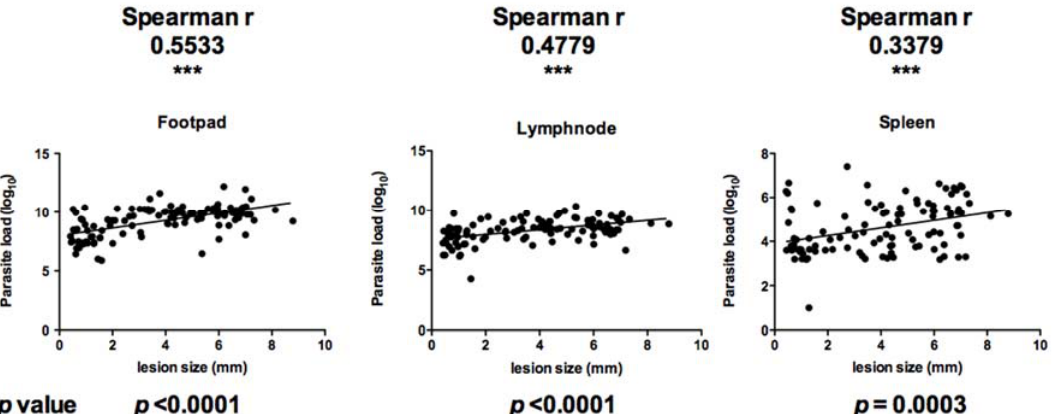
Figure 3. Correlation between the size of the lesion developed in the infected footpad, the lymph node draining the infection site, and the spleen on the one hand, and the parasite load in the corresponding organs. Correlation was measured using the non-parametric correlation coefficient Spearman r. The significance of the correlation is evaluated with the p value. *** indicate highly ( p < 0.001) statistically significant values.